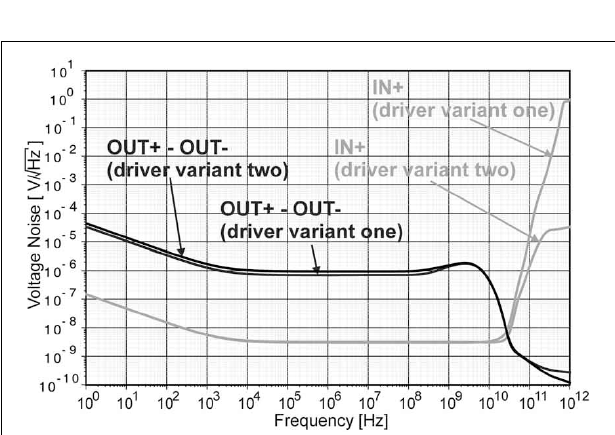
√ Hz for the output